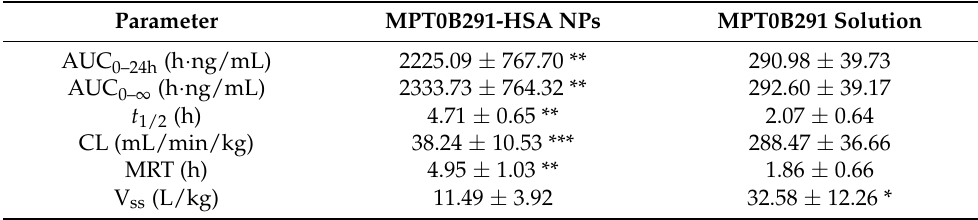
Figure 10. Plasma concentration-time curves of MPT0B291 after intravenous administration with MPT0B291-human serum albumin (HSA) nanoparticles (NPs) and an MPT0B291 solution (at a single dose of 5 mg/kg body weight) to rats. Each point represents the mean ± SD of three determi- nations ( n = 4). Table 2. Primary pharmacokinetic parameters of MPT0B291 after intravenous administration with MPT0B291-human serum albumin (HSA) nanoparticles (NPs) (at 5 mg/kg body weight) and an MPT0B291 solution (5 mg/kg body weight) to Sprague-Dawley rats. Data shown are the mean ± SD ( n =